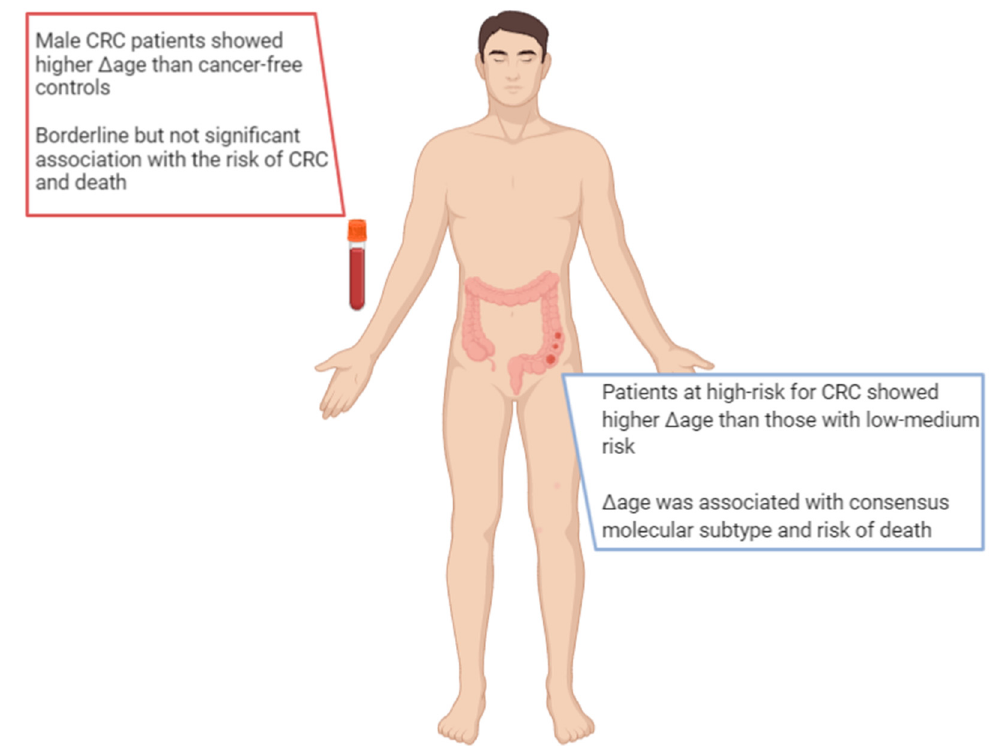
Figure 3. Main findings on epigenetic age in patients with colorectal cancer.